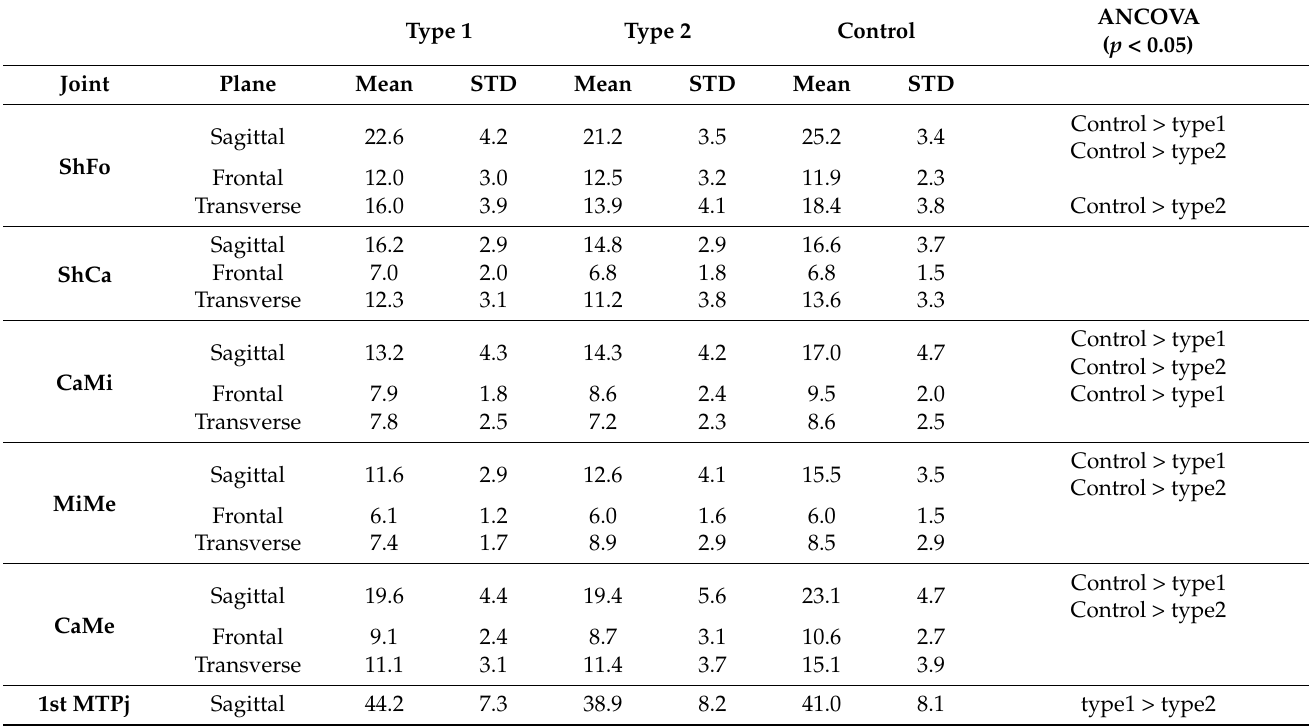
Table 3. Mean and standard deviation of foot joints ROM [deg] in stance in type 1, type 2 and control groups. The last column is reporting the ANCOVA statistically significant differences between groups using walking speed, BMI, disease duration as